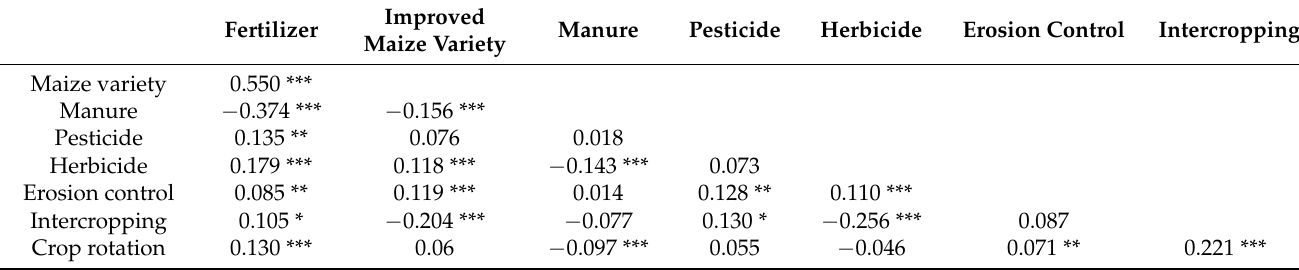
Table 4. Correlation coefficient estimates between equation error terms from the multivariate probit model.